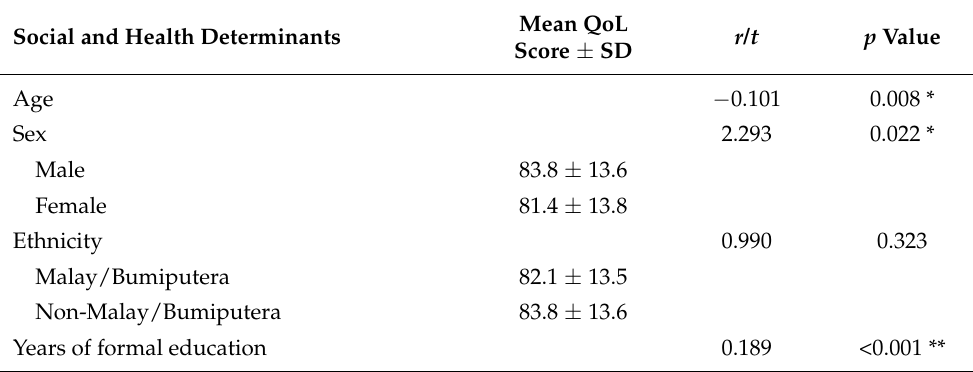
Table 2. Correlations/comparison of social and health determinants with